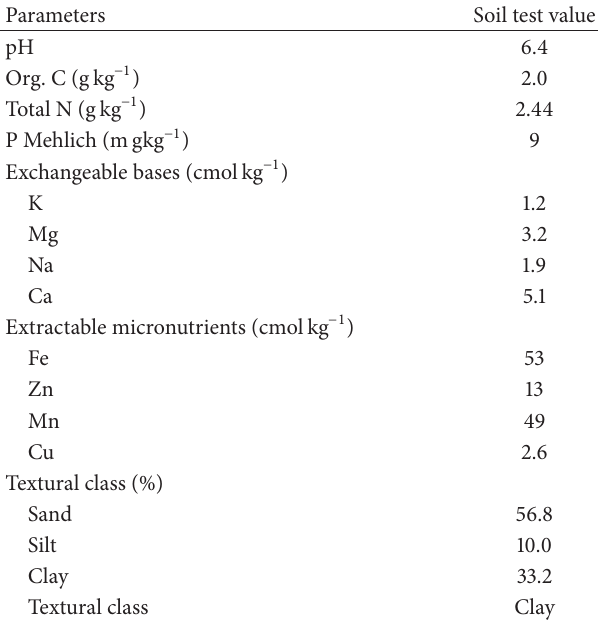
Table 2: Physicochemical properties of the experimental soil. Parameters